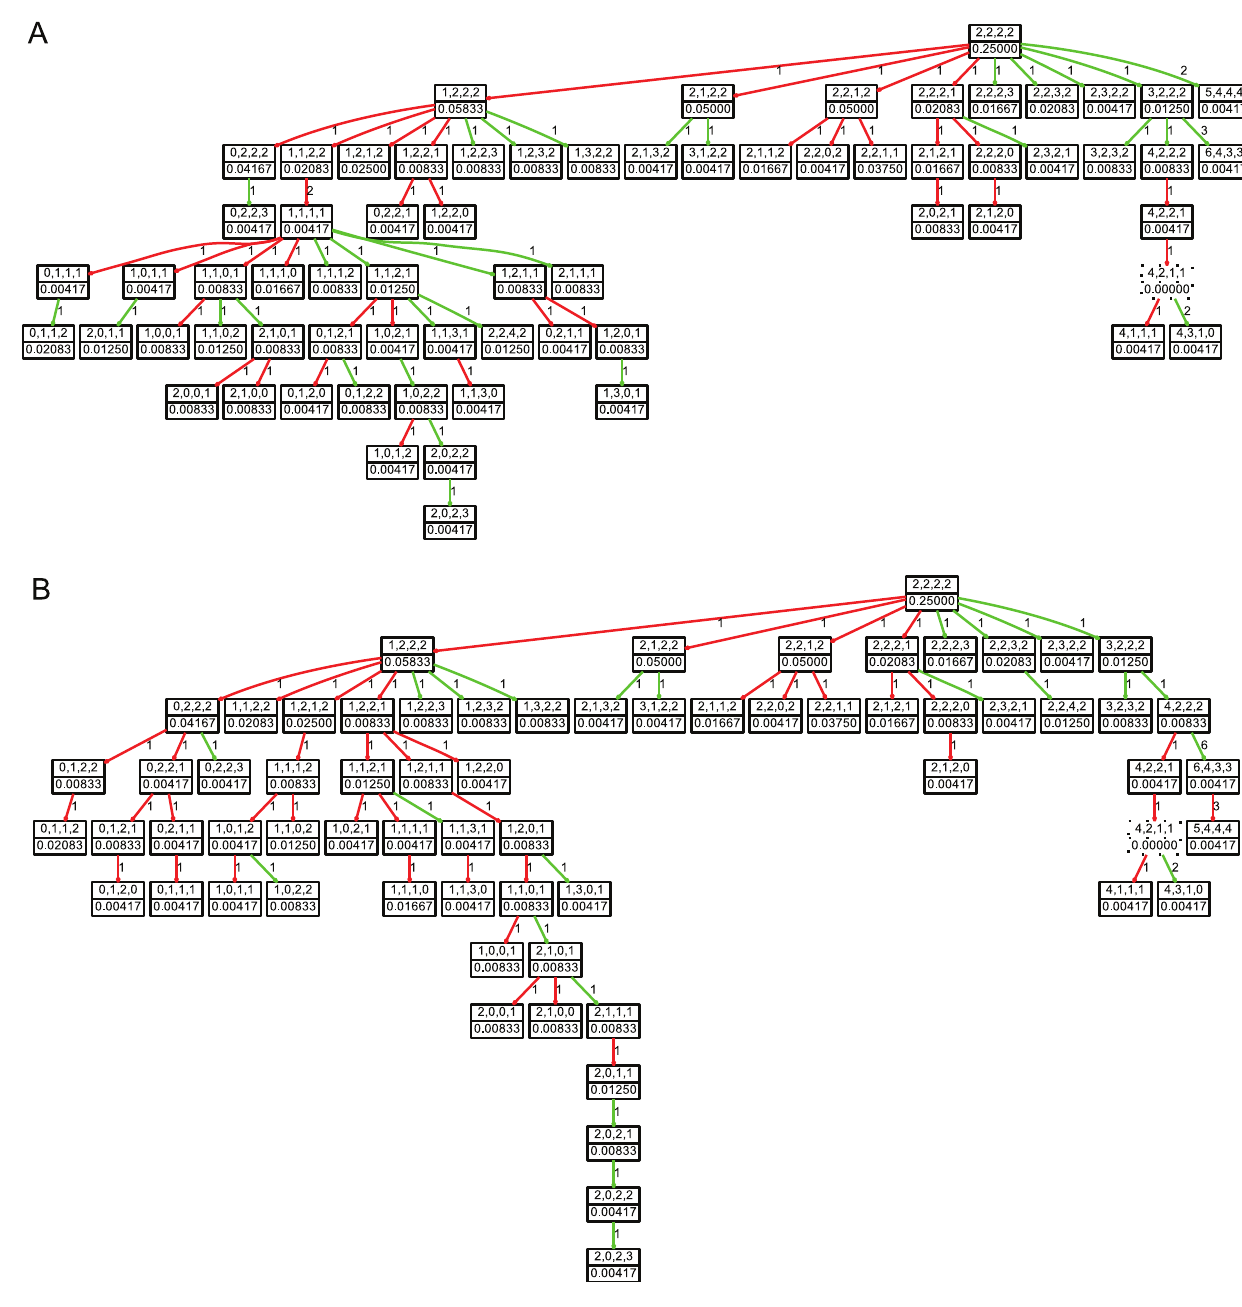
Figure 2. Phylogenetic trees showing tumor progression in a cervical cancer patient. Trees are built considering (A) all of SD, CD and GD and (B) only SD model of tumor evolution. Each node represents a configuration of the four gene probes LAMP3 , PROX1 , PRKAA1 and CCND1 . Nodes with solid and dotted borders represent cells present in the collected sample and inferred Steiner nodes respectively. Green and red edges model gene gain and gene loss, respectively. The weight value on each edge connecting two nodes x and y is the distance between the states of x and y , computed using the particular model of tumor progression under consideration. The weight on each node describes the fraction of cells in the sample with the particular copy number profile modeled by that node; Steiner nodes are assigned weight 0.